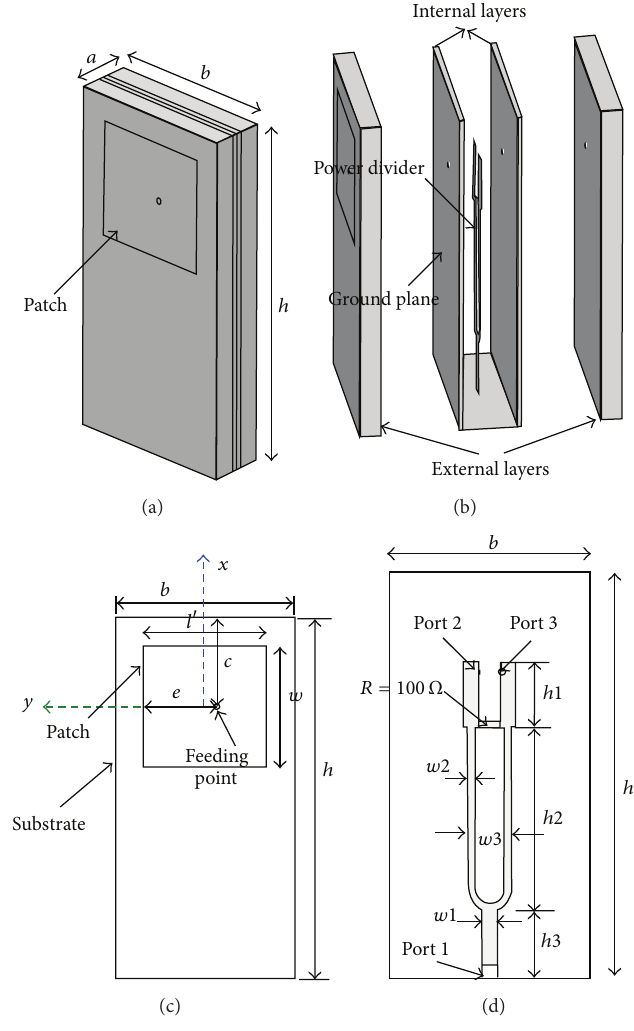
Figure 1: Model of the designed